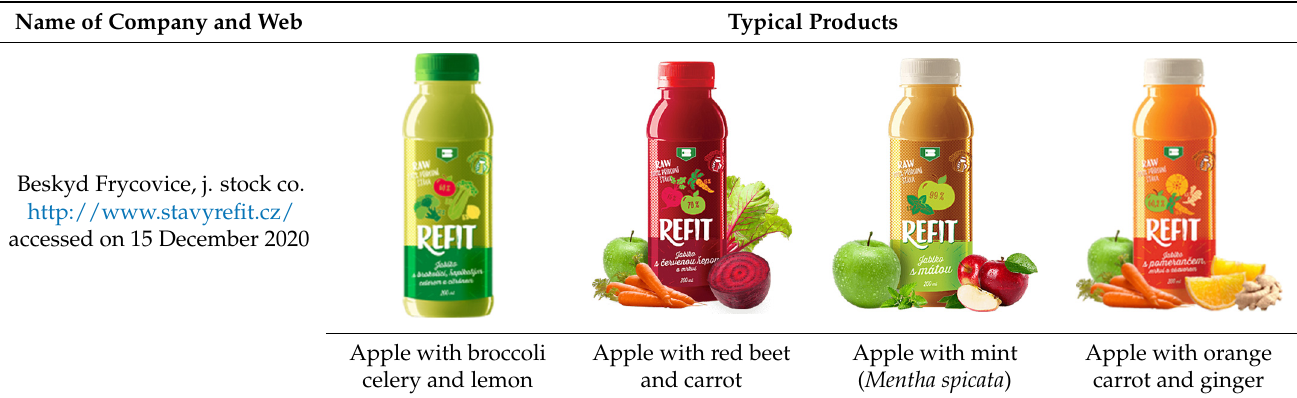
Table A2. High pressure products from the company Beskyd Frycovice.